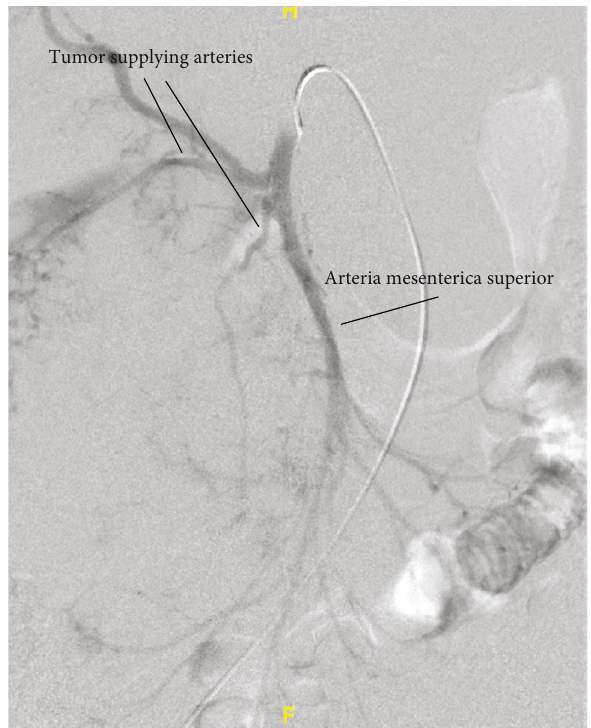
Figure 5: Angiography via a 4F-C2-catheter placed in the arteria mesenterica superior (AMS). Please note the multiple small tumor-feeding irregular and tortuous branches that arise from the AMS. The normal branches for arterial supply of the bowel present as regular, straight vessels (arrow).